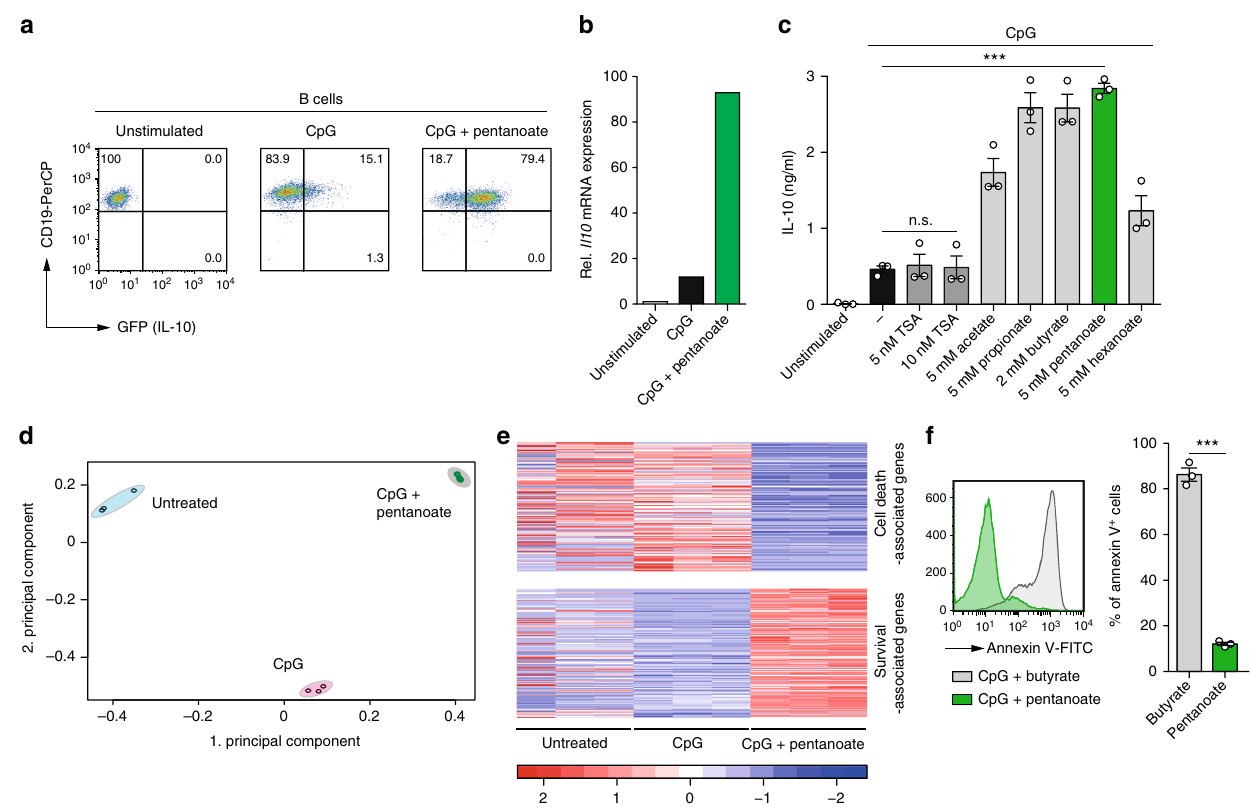
Fig. 4 Pentanoate enhances IL-10 expression in Bregs. a Splenic B cells puri fi ed from spleens of FIR × tiger mice were activated with CpG in the absence or presence of pentanoate. Representative dot plots show the frequencies of IL-10 + B cells on day 4 of the cell culture. b Representative RT-qPCR analysis of Il10 expression in Bregs treated with pentanoate for 3 days (one of three similar experiment is shown). c Bar graphs indicate secreted amounts of IL-10 by Bregs incubated for 3 days with various SCFAs or with TSA. Three experiments were performed. d , e B cells were treated as described in ( a ) and analyzed via RNA-seq. PCA ( d ) was performed on FPKM values. Heatmap ( e ) of cell death- and survival-associated genes, regulated upon pentanoate treatment, and overlapping with gene sets based on the IPA-database are shown. FPKM values of overlapping genes were z-transformed and plotted. f Histogram (left) and bar graphs (right) showing the frequency of Annexin V + Bregs treated with SCFAs pentanoate (5 mM) or butyrate (5 mM) for 24 h. Three independent experiments were performed. Error bars indicate SEM. n.s. = not signi fi cant, ** P < 0.01, *** P < 0.001 (Student's t